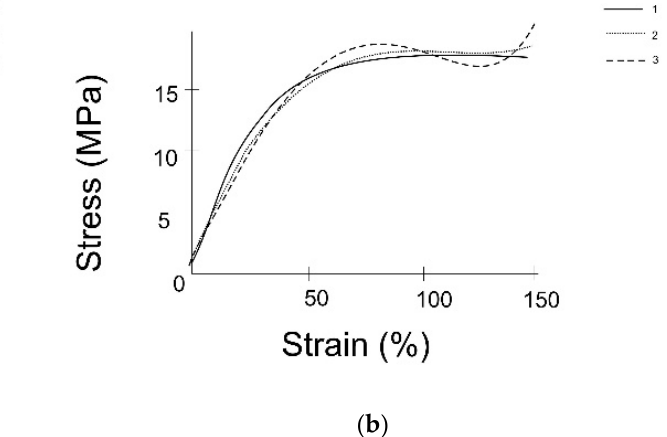
Figure 5. Stress–strain diagrams: ( a ) specimen 1, ( b ) specimen 2. The solid line (1) is the experimental curve, the dashed line (2) is the five-parameter Mooney–Rivlin strain energy density function, and the dotted line (3) is the three-parameter Yeoh strain energy density function. Table 3. Mechanical properties of samples. Table 5. Mechanical parameters for aorta and shunt used in the